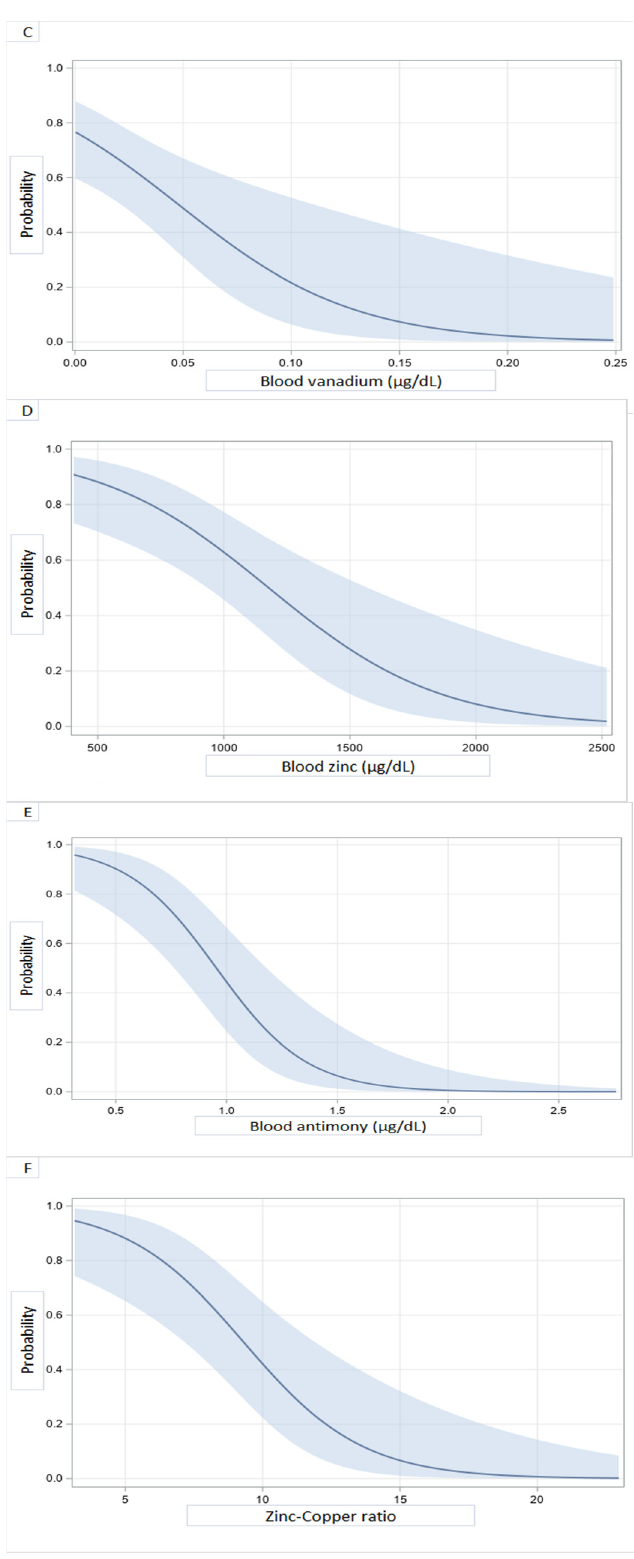
Figure 2. Illustrative predicted probabilities of DCM as a function of blood heavy metal concentrations: arsenic ( A ), copper ( B ), vanadium ( C ), zinc ( D ), antimony ( E ), and zinc/copper ratio ( F ).